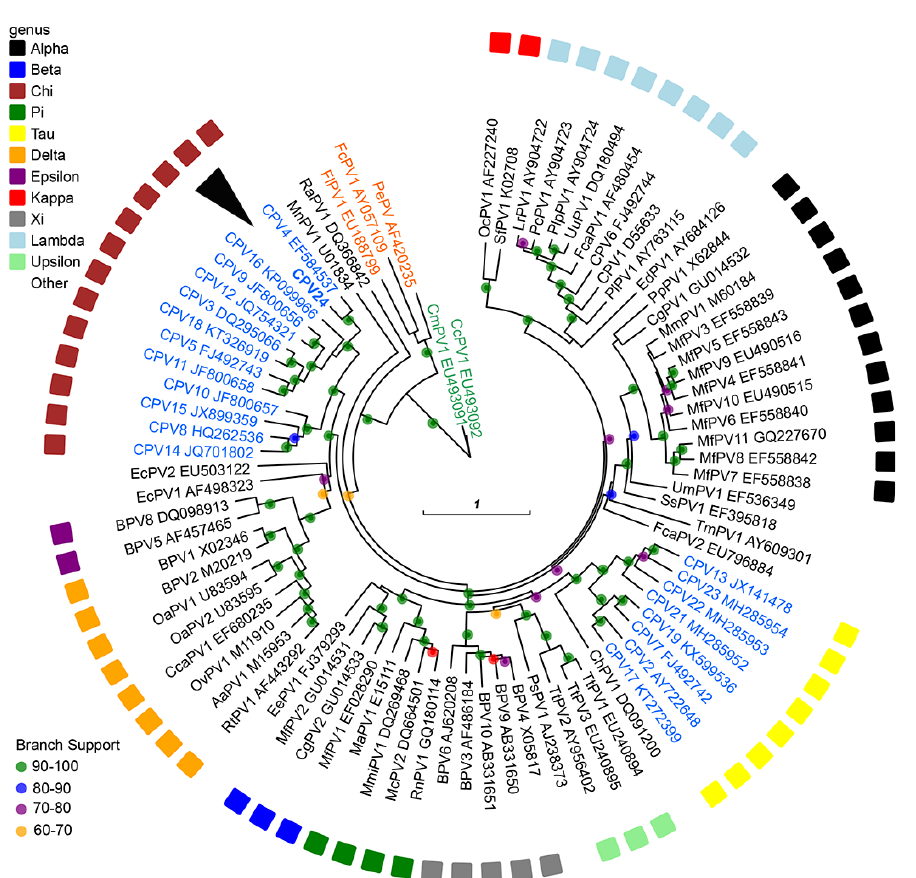
Figure 3. Unrooted Maximum likelihood phylogeny based on concatenated nucleotide alignment of E1, E2, L1 and L2 ORF sequences from putative CPV24 (arrowhead) with 84 other PV types of different species and genera. Accession numbers for the sequences used are included. Abbreviations